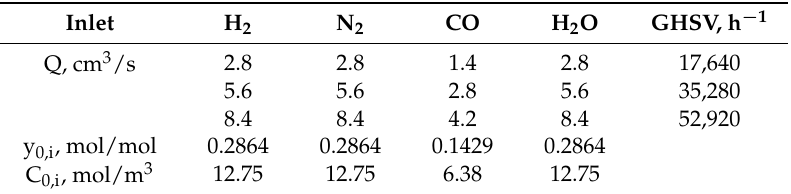
Table 4. Feed characteristics of a four-component